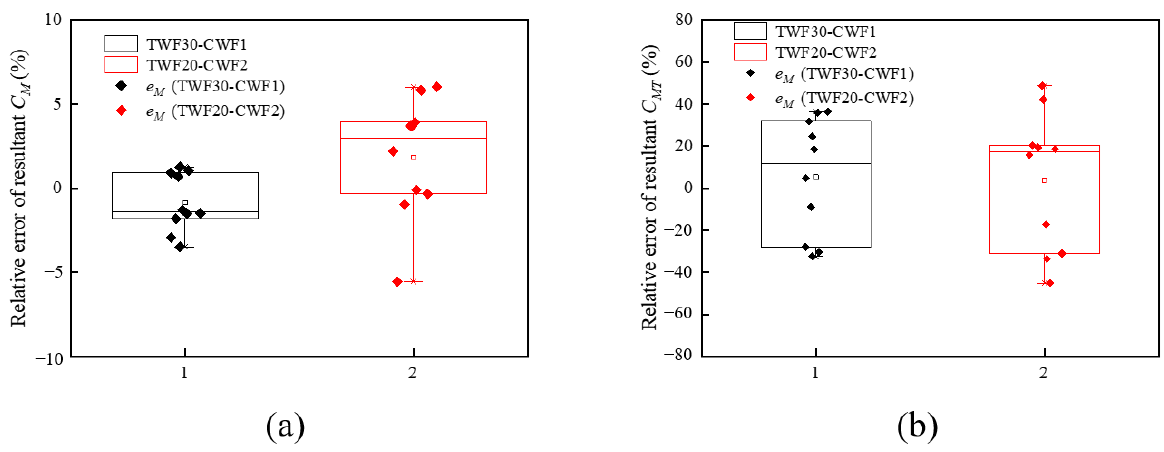
Figure 16. Relative errors of ( a ) C M and ( b ) C MT between CWFs and TWFs.